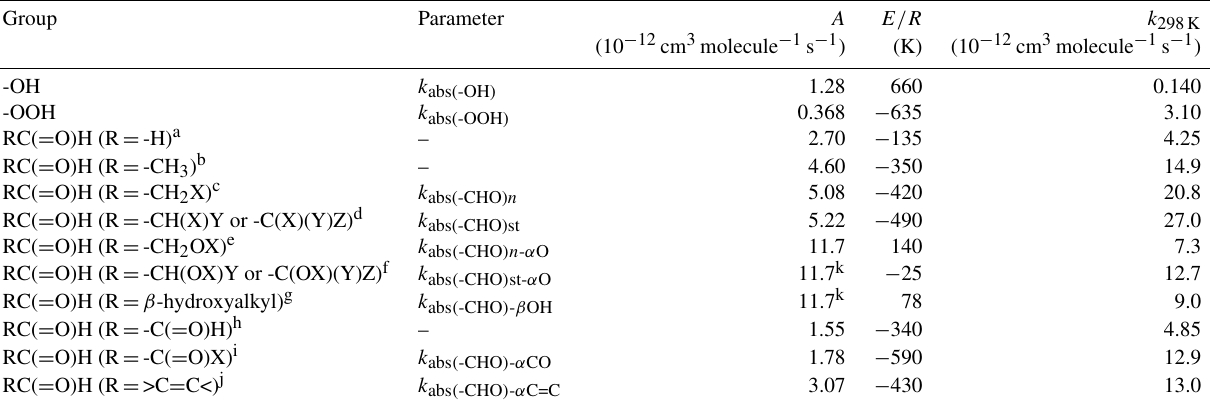
Table 4. Arrhenius parameters ( k = A exp ( − (E/R)/T ) ) for the rate coefficients for H-atom abstraction from hydroxy and hydroperoxy groups, and for the formyl group in RC ( =O ) H for various classes of R, and their values at 298K. These values are applied independently of neighbouring group substituent